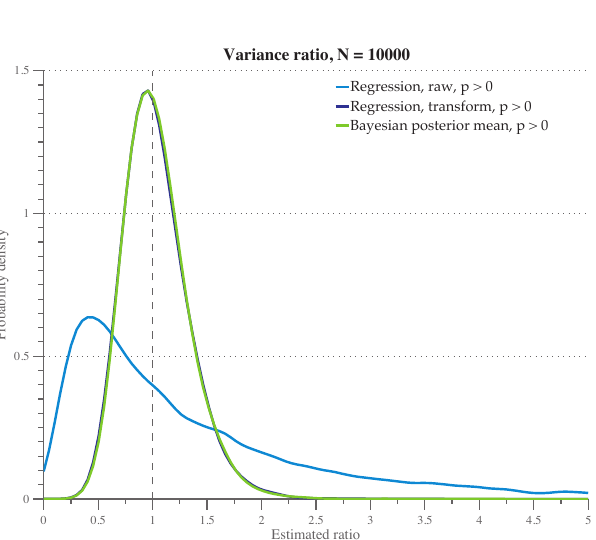
Figure 6. Distribution of variances ratios between the calibration and validation intervals, as inferred from each method and nor- malized by the same ratio calculated from the actual realization of c ( t ). Cyan: raw regression; blue: regression on transformed pseudo- proxies; green: Bayesian inversion. The black dashed line denotes unity, which, due to the normalization, is the result under perfect inference for each realization of c ( t ). Distributions are based on 10000 realizations of c ( t ) with δ = 0 .